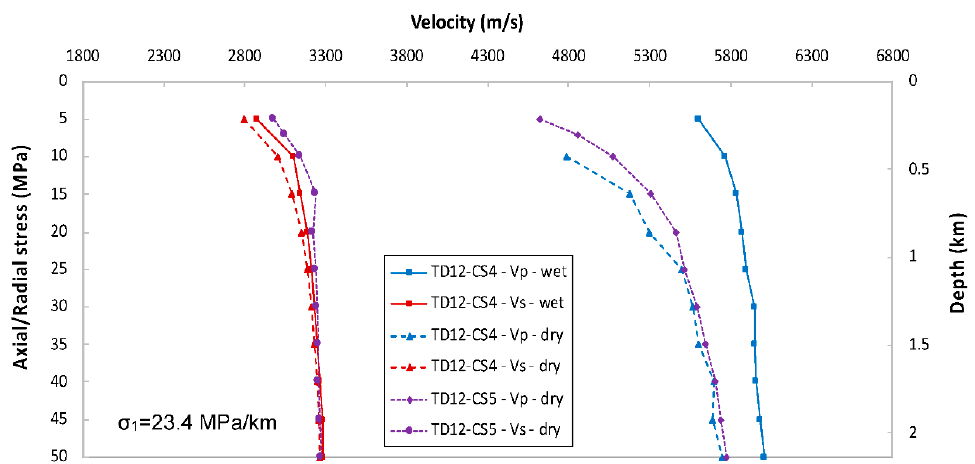
Figure 11. P-wave (blue) and S-wave (red) velocity as a function of axial stress, and thus depth below the surface, for a dry and wet (25 ± 2% brine) fractured calcschist sample (TD12-CS4). For comparison purposes, results related to intact calcschist sample TD12-CS5 (from experimental series B) are shown as well (purple). Axial stress–depth relationship is taken from [35].